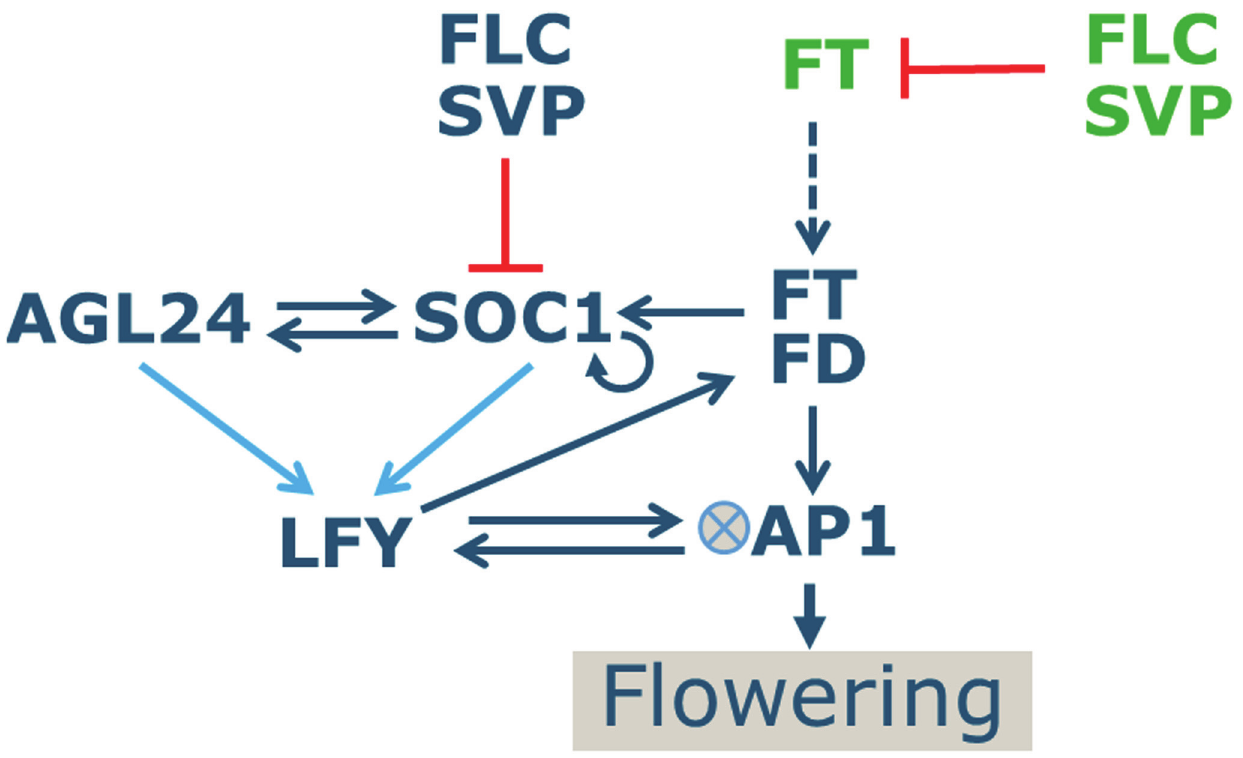
Fig 1. Network of flowering time integrator genes. Green indicates expression in leaf tissue, blue in meristem tissue. Red arrows represent repression, blue arrows activation. Most interactions were taken as given based on literature information, but for regulation of LFY by AGL24 and SOC1, different ways of combining the two inputs were tested (indicated by the light blue arrows). Dashed arrow represents FT transport. Junction symbol next to AP1 indicates cooperativity predicted for regulation of AP1 by LFY. As indicated, AP1 expression is used as a marker for the moment of the floral transition. This network was used to fit expression time-course data and to predict the effect of perturbations. Gene names are given in full in the text.